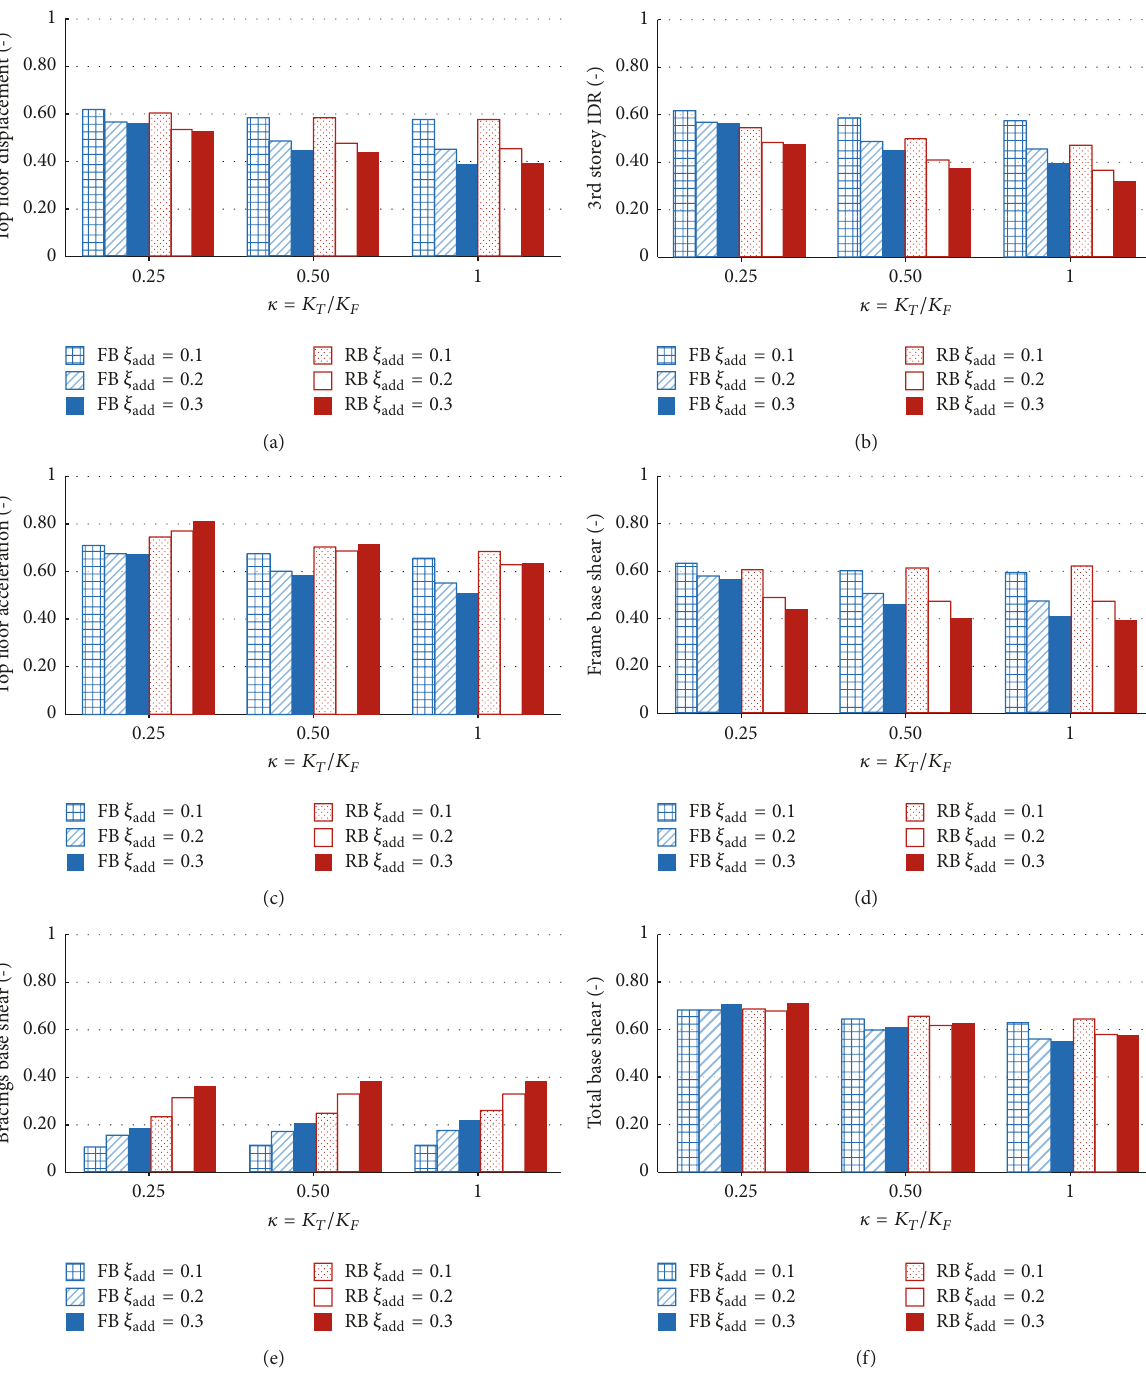
values. On the other hand, the retrofit effectiveness of the FB configuration reduces significantly by considering external frames with 𝜅 = 0.25 rather than 𝜅 = 0.5 or 𝜅 = 1. Figure 12(e) describes the base shear resisted by the external